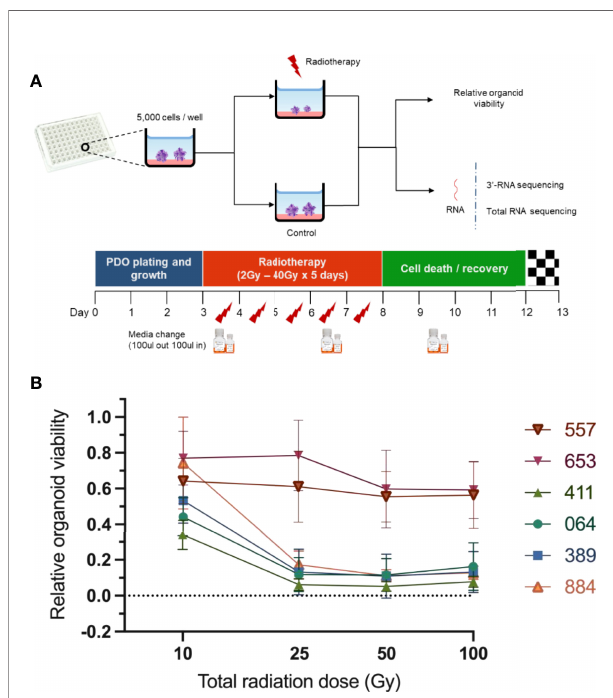
FIGURE 2 | Assessment of PDO lines response to radiotherapy. (A) Scheme illustrating experimental design. The PDO lines were cultured in 96-well plates (5000 organoid cells/well) and treated with different radiotherapy doses ranging from 2Gy x 5 days to 20Gy x 5 days. A chemiluminescence-based assay (CellTiter-Glo ® 3D) was then used to assess relative PDO. (B) Radiation response curves of PDO lines from three independent experiments (error bars represent standard